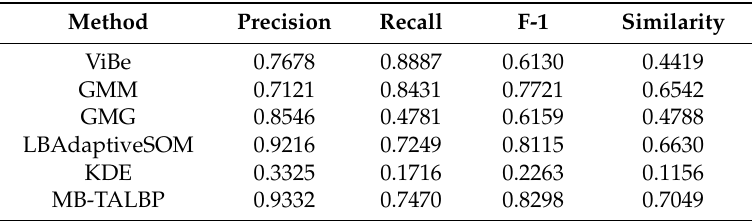
Table 2. Comparison of indexes of “Rabbit in the